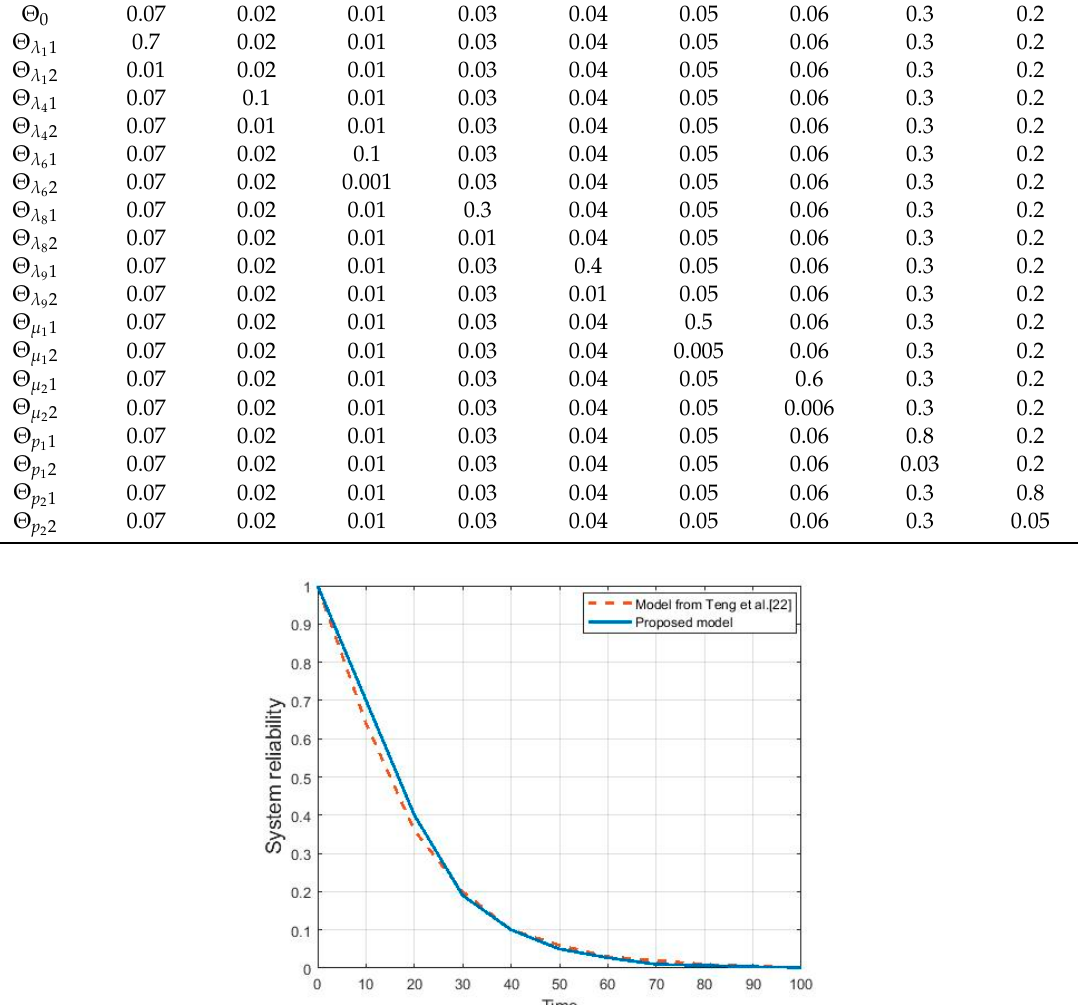
(cid:3284) (cid:2879)(cid:3038) − k . i